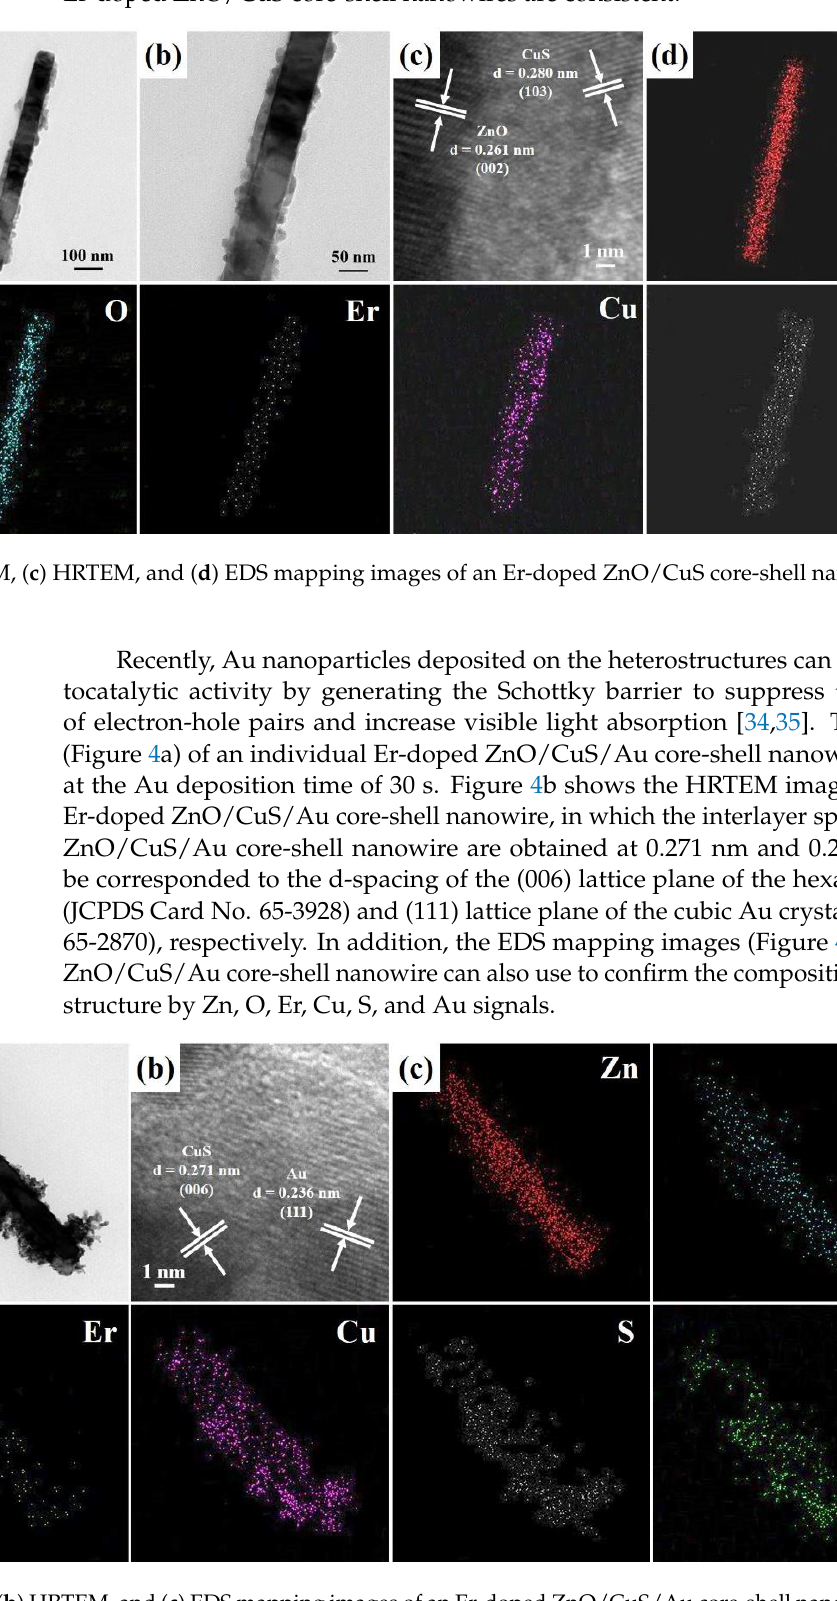
Er-doped ZnO/CuS core-shell nanowire is shown in Figure 3c. The interlayer spacings of